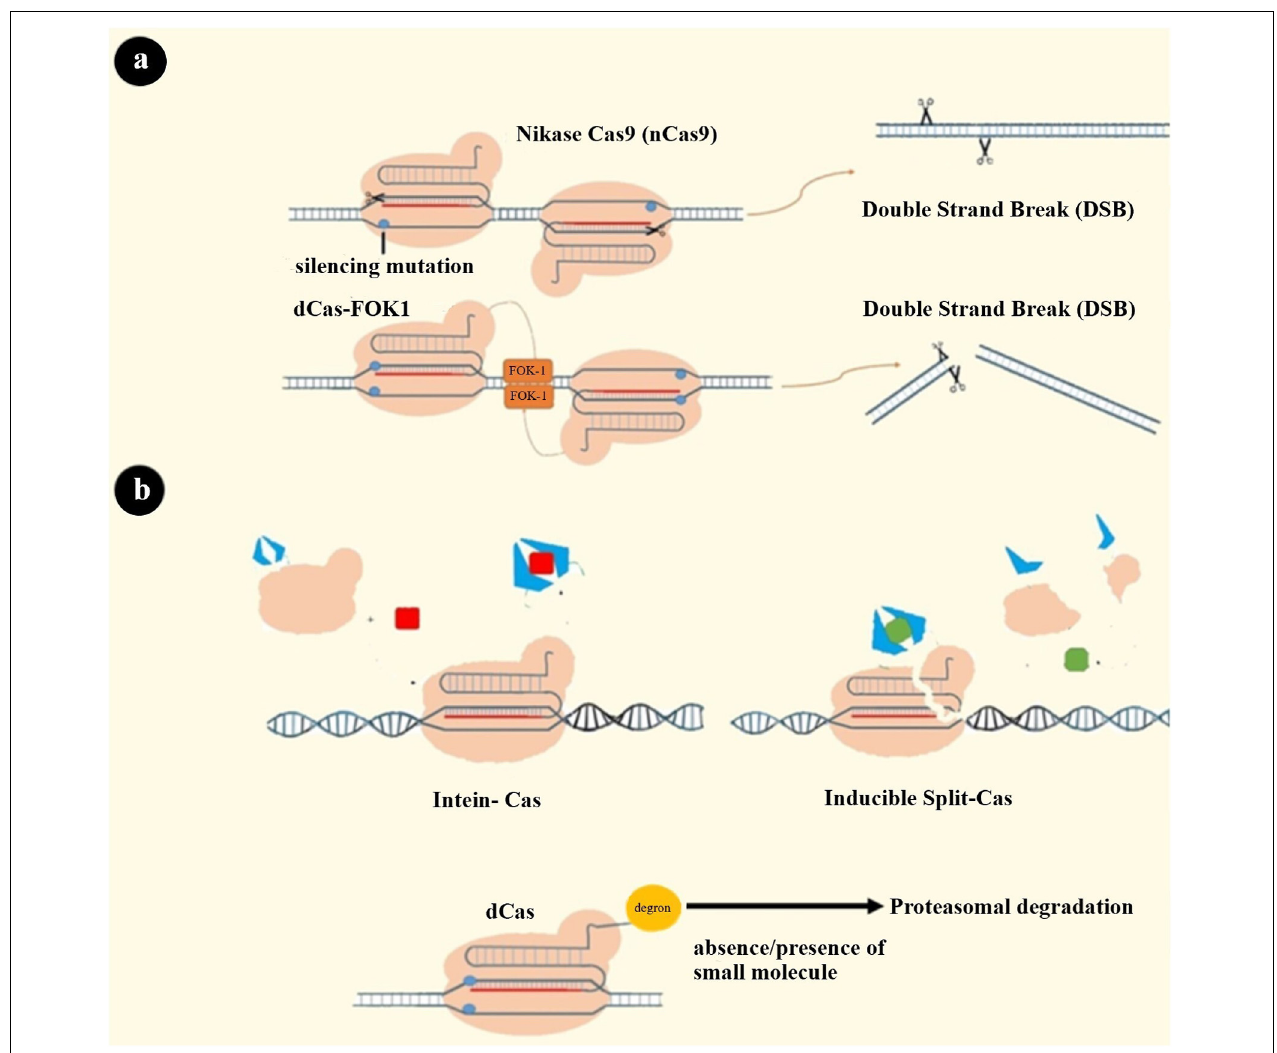
FIGURE 4 | Some strategies to solve CRISPR system limitations. (a) Systems that need dimerization to cleave both strands: 1. dCas-FOK1 2. nCas9. (b) Cas9 variants’ activity can be switched on and off by cell-permeable molecules: (1) Intein-Cas9 is activated by excision of the intein bound to a specific position in Cas9. A cell-permeable small molecule induces this excision (189, 211). (2) Split-Cas9 is a Cas9 molecule that has been split into two fragments, and these two can be dimerized via drug-binding dimerization domains and a cell-permeable drug (212). (3) Degron-Cas9 is formed by binding a destabilizing domain (degron) to Cas9 protein. Previous studies have introduced a different type of degron that can bind to the protein of interest and decrease the stability of that protein in the presence or absence of specific small molecules. Degron domains can also be fused to the RBP-effector complex to regulate its stability and activity of the CRISPR system as a result (190,